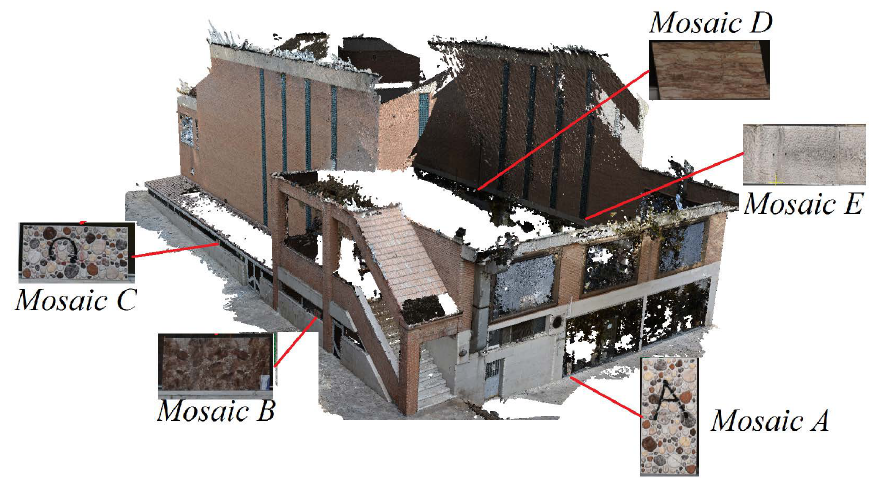
Figure 26. The locations of the mosaics placed on the building façades.